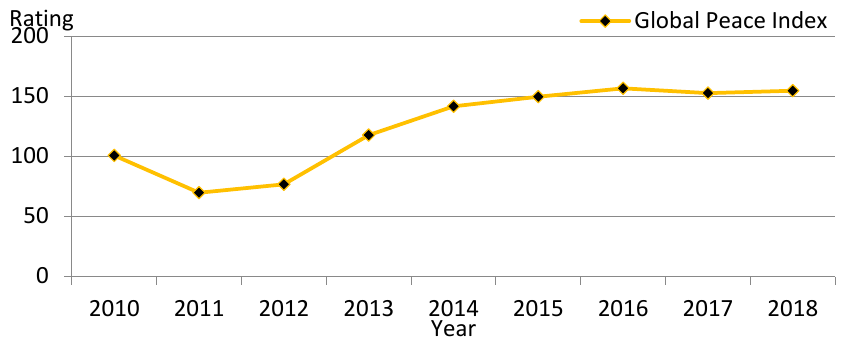
Fig. 2: Global Peace Index of Ukraine (UIR, 2019)